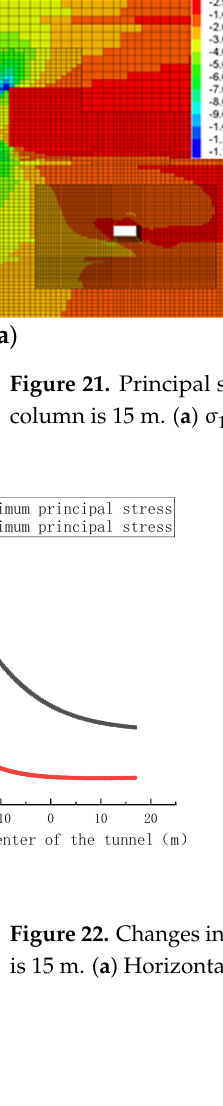
Figure 22. Changes in the principal stresses of the roadway’s surrounding rock when the coal column is 15 m. According to the plastic zone distribution cloud map (Figure 23), the maximum damage depth of the plastic zone of the roadway is 5.5 m, and the range further increases. The distribution pattern is similar to those above the 4 m and 8 m coal pillars. When the coal pillar’s size is 20 m, this condition is consistent with the situation of the roadway dug along the bottom in the previous subsection, and it will not be repeated here. The maximum depth of damage in the plastic zone of the roadway is 6 m, and the extent of the plastic zone continues to grow.